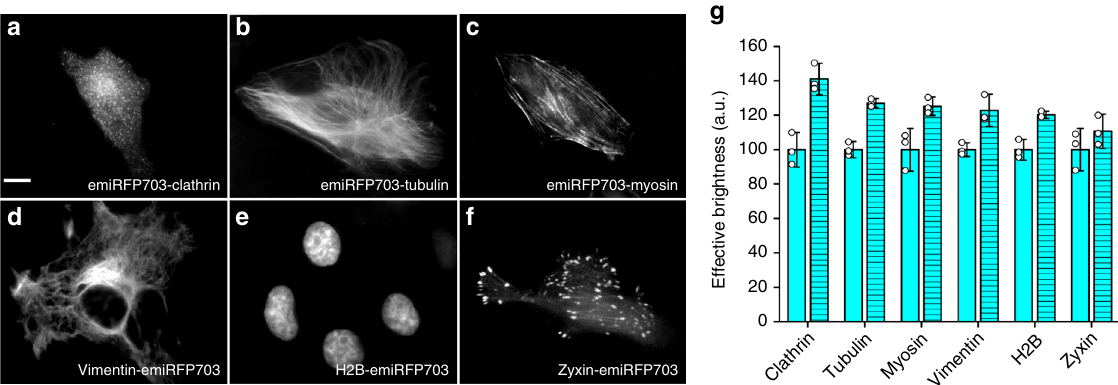
Fig. 3 Fusions of emiRFP703 with cellular proteins. a – f Fusions of emiRFP703 labeling clathrin ( a ), tubulin ( b ), myosin ( c ), vimentin ( d ), H2B ( e ) and zyxin ( f ) in HeLa cells. g Effective brightness of miRFP703 (plain) and emiRFP703 (hatch pattern) fusions in HeLa cells 72 h after transfection. Scale bar, 10 µ m. Error bars, double s.e.m. ( n = 3; transfection experiments).